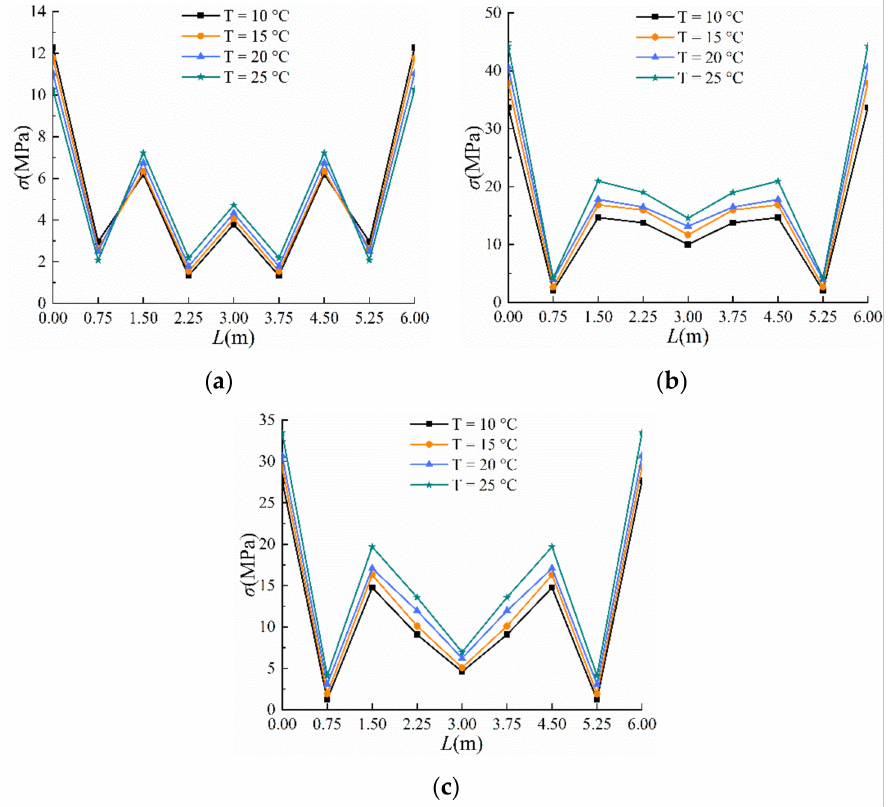
Figure 15. The stress–temperature relationship of ( a ) the crown beam, ( b ) waist beam 1, and ( c ) waist beam